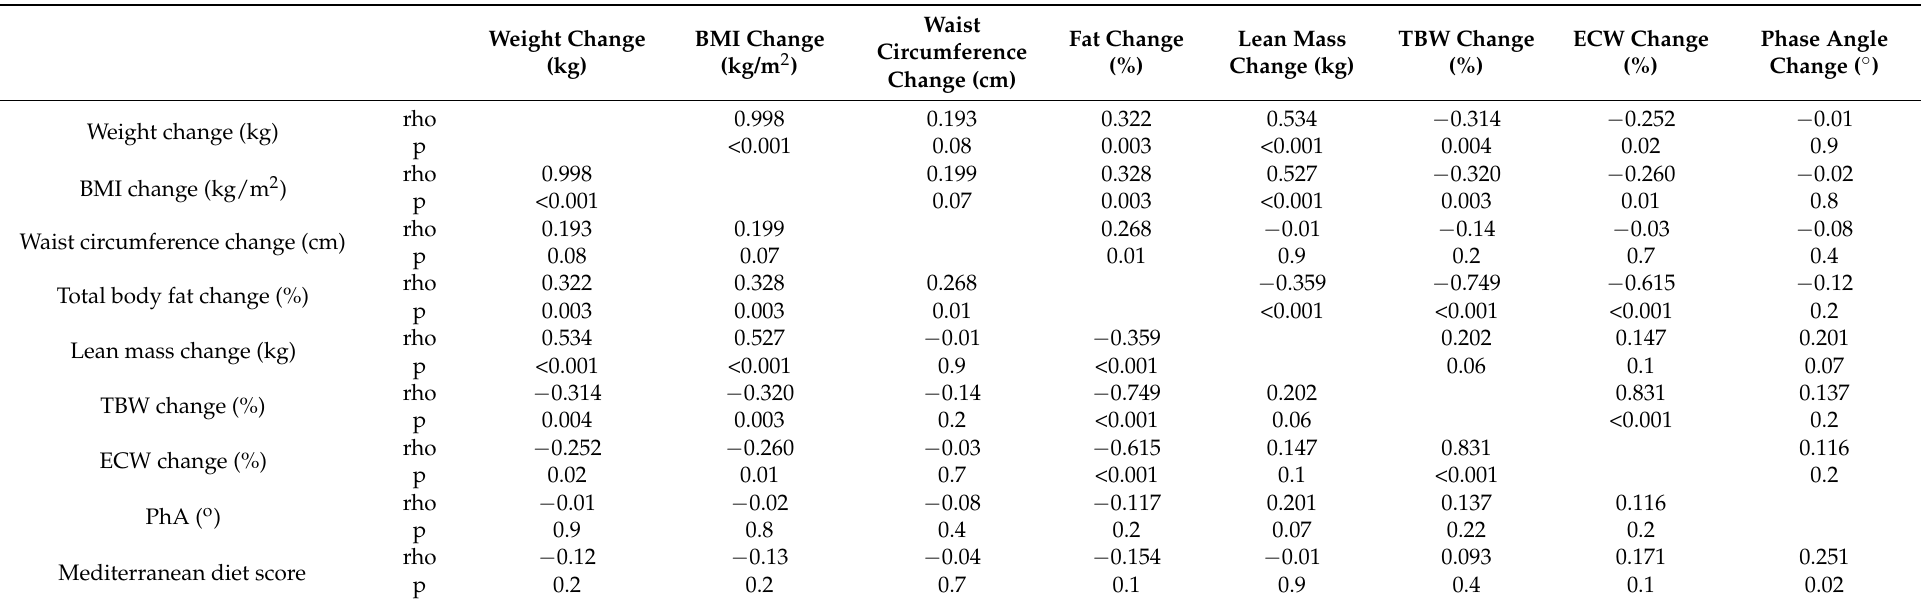
Table 4. Spearman correlation coefficients between changes in weight, body composition variables, and